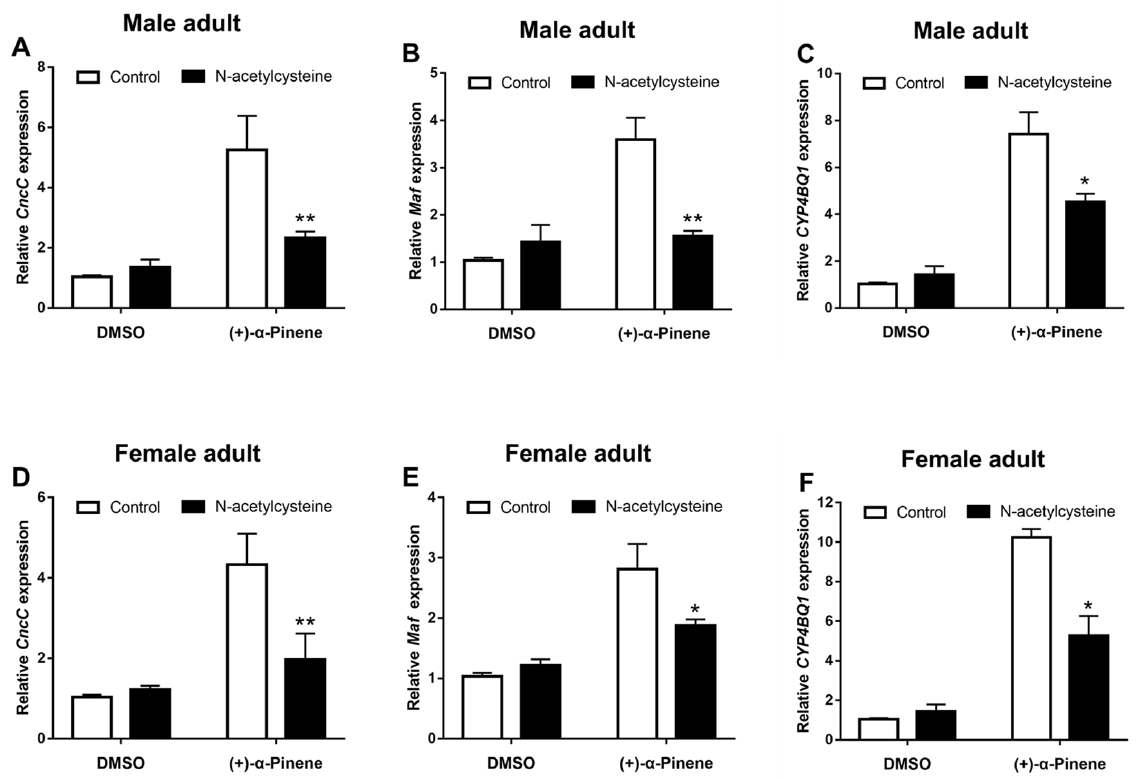
Figure 6. Effects of ROS scavenging on the expression of (+)- α -pinene-induced CncC ( A , D ), Maf ( B , E ), and CYP4BQ1 ( C , F ) genes. The adults of D. armandi reared on normal (control) or 2% NAC diets were treated with DMSO or (+)- α -pinene for 24 h. The asterisk indicates a significant difference between treatment groups (* p < 0.05, ** p < 0.01, independent Student’s t -test). All values are the mean ± SE, n = 3.